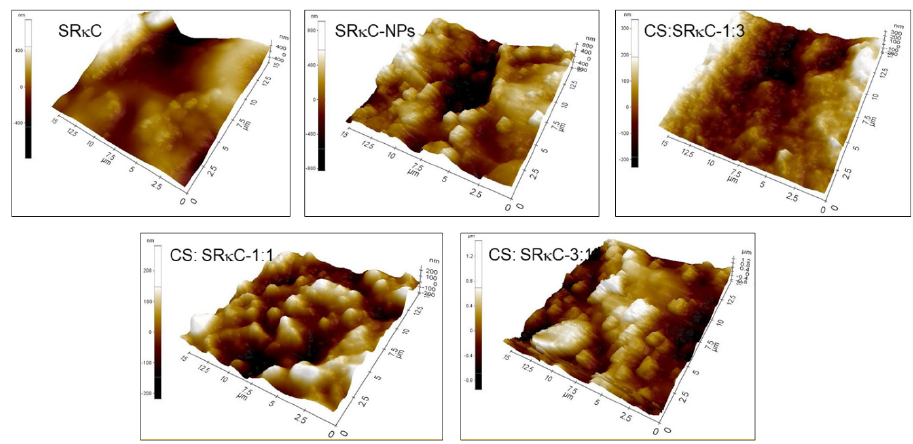
Figure 5. AFM images of SR κ C films at various CS